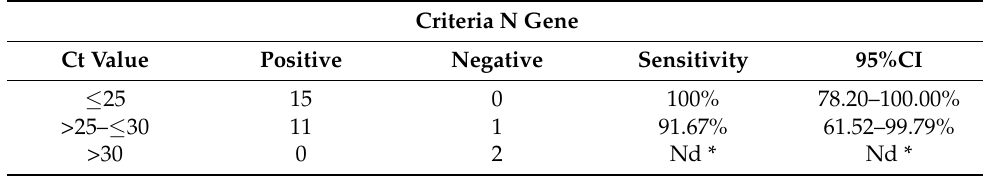
Table 2. Clinical sensitivity of the GenBody COVID-19 Ag test (COVAG025) based on Ct values.